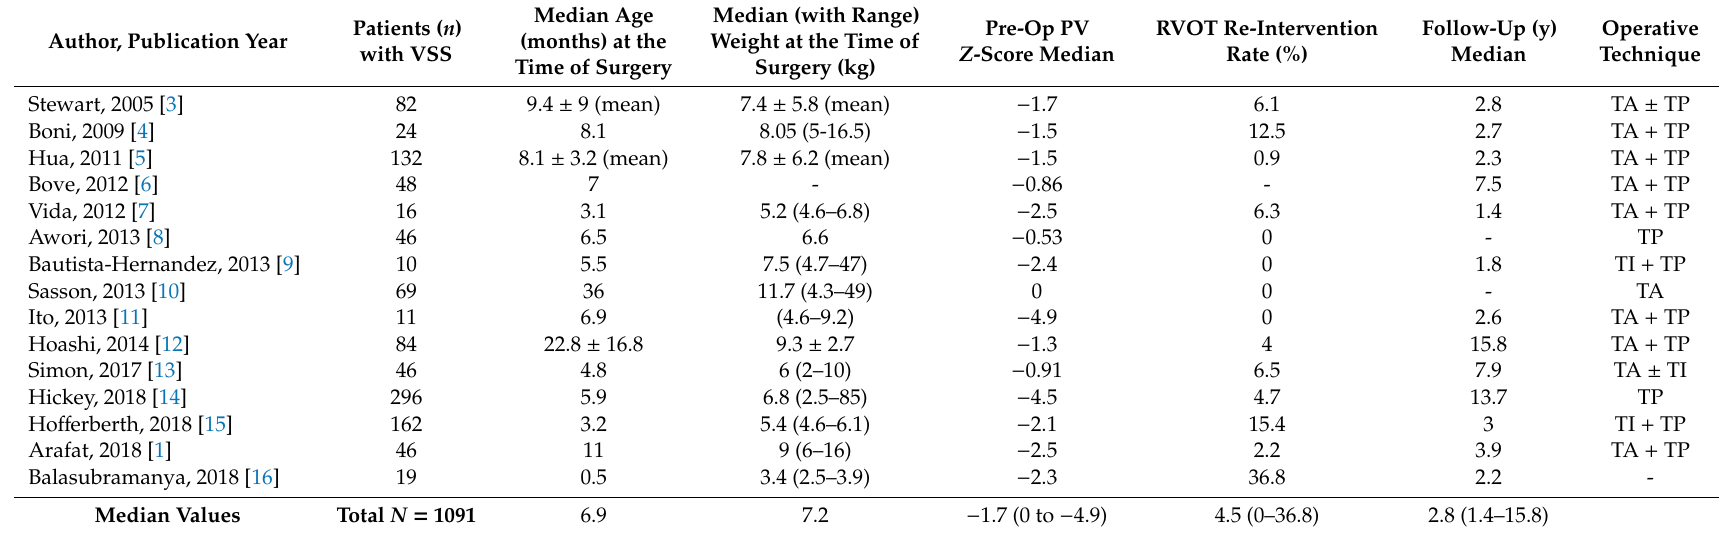
Table 1. Patient